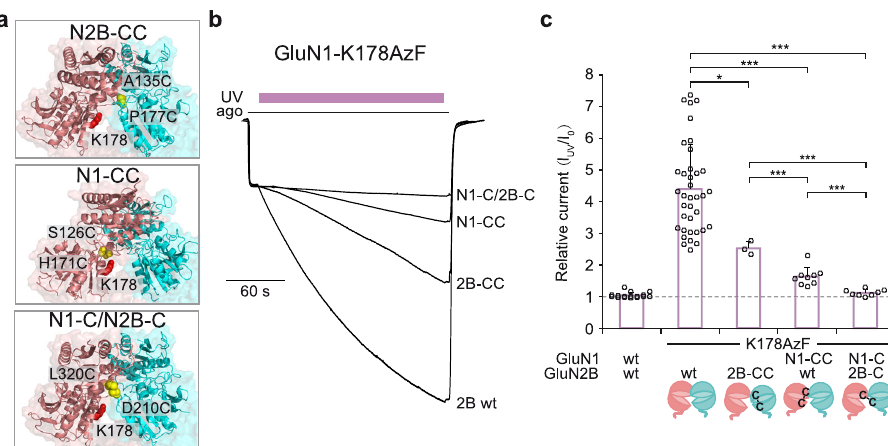
Fig. 2 Photopotentiation necessitates inter-subunit mobility of the GluN1/GluN2B NTD heterodimer. a Location of each double cysteine mutations (CC) in the GluN1/GluN2B NTD heterodimer (PDB 4PE5, Ref. 10 ). Mutant receptors are GluN1-K178AzF/GluN2B-A135C-P177C (2B-CC), GluN1-S126C-H171C- K178AzF/GluN2B wt (N1-CC) and GluN1-K178AzF-L320C/GluN2B-D210C (N1-C/2B-C). Introduced cysteines are highlighted as yellow spheres and the GluN1-K178 position as red spheres. b Responsiveness of disul fi de-bond linked mutant receptors to UV illumination (365 nm). Representative current traces measured from oocytes expressing wild-type (wt) or various cysteine mutant receptors (as described in a) during UV illumination. Note that the UV-induced potentiation is almost completely lost on receptors with inter-subunit disul fi de bond cross-linked NTDs (N1C/2B-C). ago, for agonists (glutamate and glycine, 100 µ M each). c Change in current amplitude upon UV illumination (I uv /I o ) of wild-type (wt) GluN1/GluN2B receptors and cysteine mutant receptors (as described in a). Values are: 1.04 ± 0.09 ( n = 16) for wt, 4.39 ± 1.40 ( n = 37) for GluN1-K178AzF/GluN2B, 2.52 ± 0.21 ( n = 3) for 2B-CC, 1.63 ± 0.29 ( n = 9) for N1-CC and 1.12 ± 0.10 ( n = 8) for N1-C/2B-C. Bottom cartoons illustrate the introduced disul fi de bond pair and their impact on NTD clamshell closure. Data represent mean ± SD. n = number of biologically independent cells. * P = 0.030, *** P < 0.001 (one-way